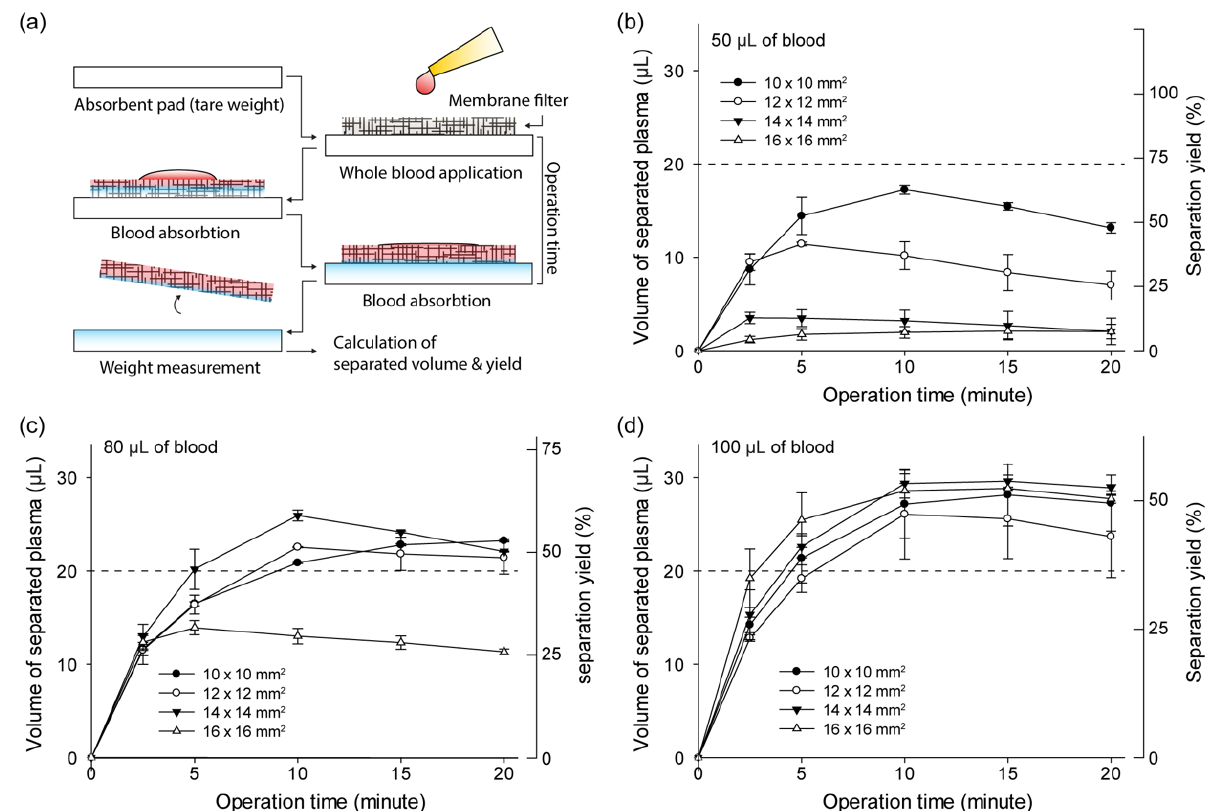
Figure 2. Evaluation of plasma separation performance of membrane filter according to the filter sizes and volume of whole blood. ( a ) Weight-based evaluation process using the absorbent pad. Blood plasma separation volume and yield of the membrane filter from 50 µ L ( b ), 80 µ L ( c ), and 100 µ L ( d ) of whole blood (N = 8, error bars indicate standard deviation).